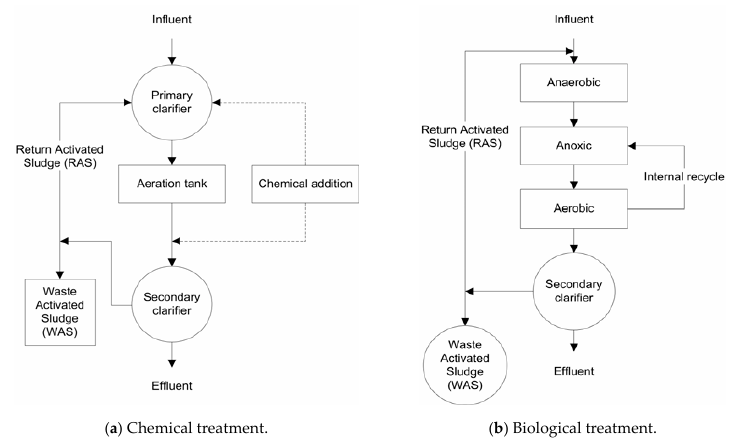
Figure 1. Flow charts of phosphate removal methods in Korea WWTP.